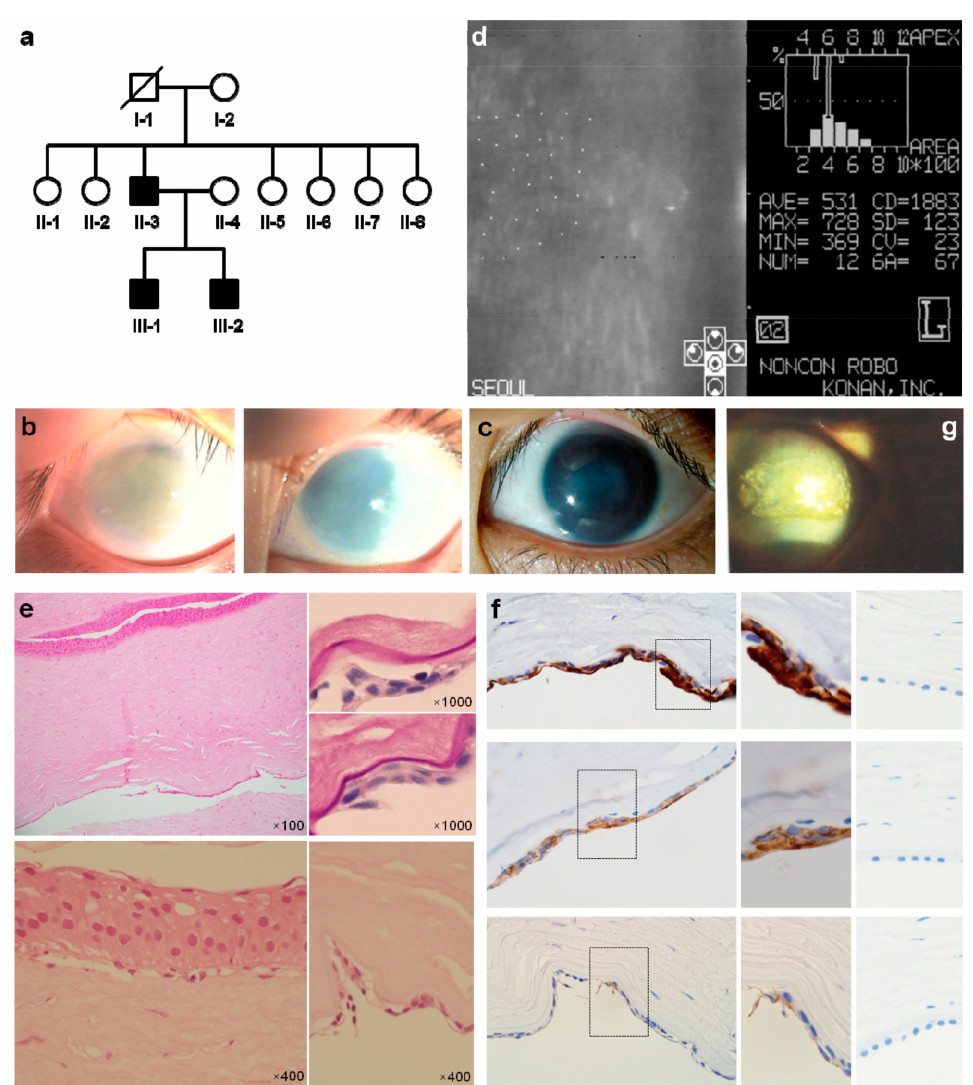
Figure 1. Clinical, ophthalmological and pathological characteristics. ( a ) Pedigree of a ff ected family showing autosomal dominant inheritance. ( b ) Slit-lamp photograph of an 8-year-old boy (III-1) showing bilateral di ff use-marked corneal edema (left: left eye, right: right eye). The corneal diameter was not enlarged and no other corneal abnormalities, such as Haab’s striae or endothelial vesicles and lines, were observed. ( c ) Slit-lamp photograph of his younger brother (III-2) at the age 18. Corneal edema with a di ff use ground glass appearance was noticed in his left eye. There was no corneal vascularization. Descemet’s membrane appeared thickened. ( d ) The central corneal thickness (III-2) was 861 µ m and the endothelial cell density was 1883 cells / mm 2 . ( e ) The cornea (III-2) shows increased thickness due to edema of basal epithelial cells and stroma, and abnormal metaplastic endothelium with stratified epithelium-like changes. Hematoxylin and eosin staining and Periodic acid-Schi ff staining. ( f ) Patient’s metaplastic corneal endothelial cells express predominantly cytokerain 7 (CK7) (upper), CK19 (middle), and E-cadherin (lower) while they were not expressed in control corneal endothelial cells (right). ( g ) Slit-lamp photograph of patients’ father (II-3) at the age of 45 showed spheroidal corneal degeneration with